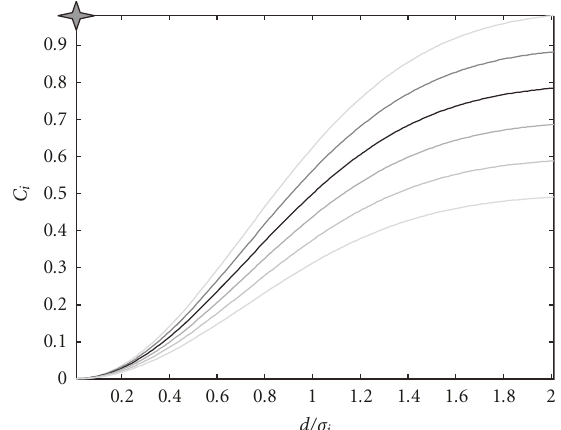
Figure 3: Cost function dependency on distance from the cluster centre for values of parameter α ∈ [0 . 5,1 .